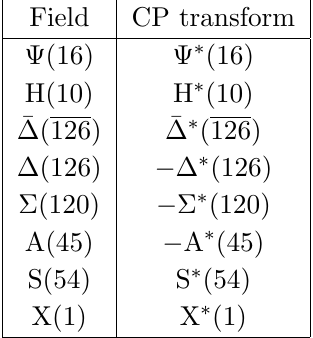
Table 1 . CP transformations of the super(cid:12)elds of the theory in the (cid:12)rst